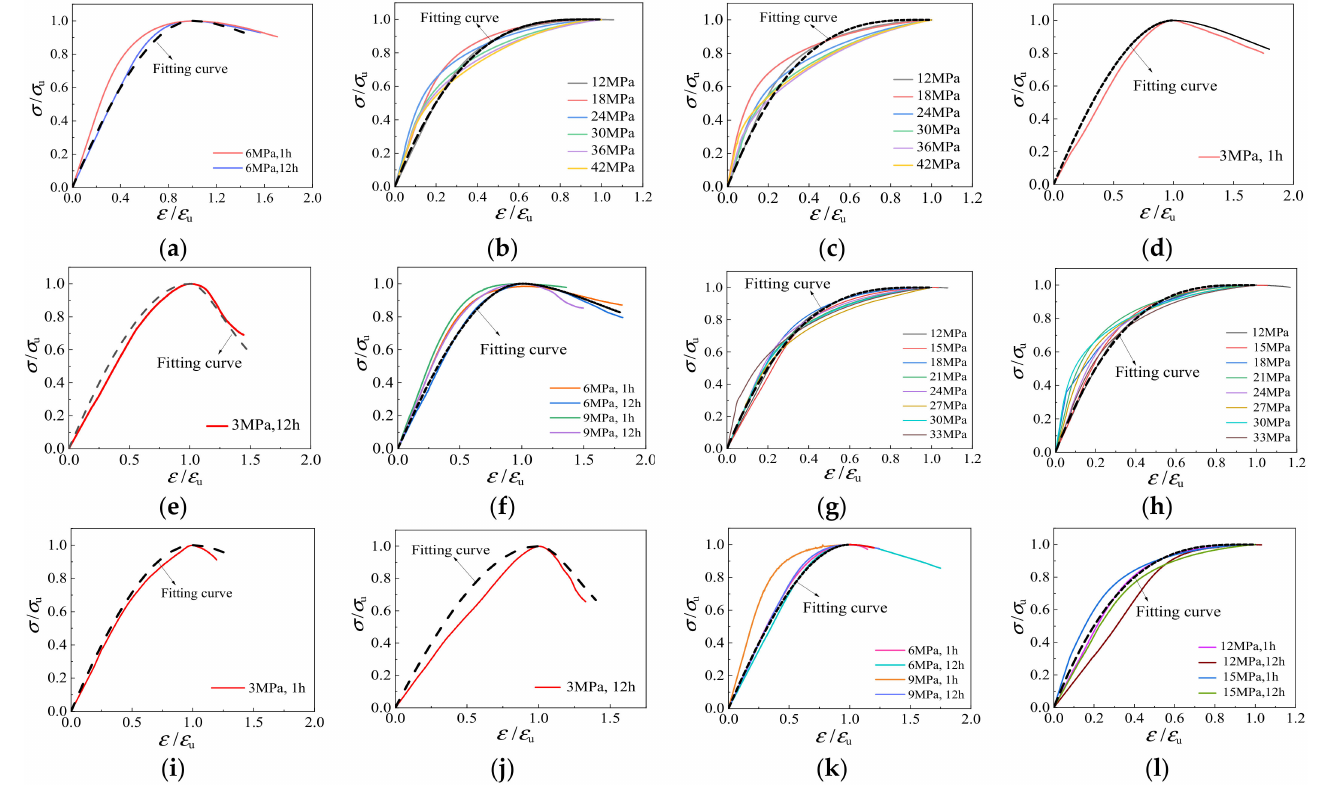
Figure 19. Comparison of test curve and fitting curve under different parameters. ( a )